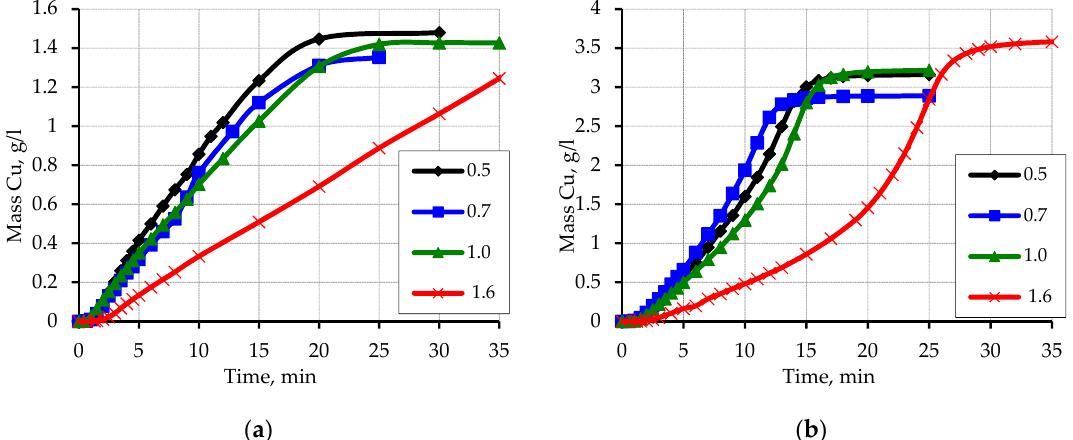
Figure 7. Kinetic curves of copper ion reduction on the activated surface of polypropylene depending on the particle size. Concentration (mmol / L): ( a ) CuSO 4 –48; EDTA-Na 2 –67; NaOH–560; formaldehyde–366. ( b ) CuSO 4 –80; EDTA-Na 2 –67; NaOH–560; formaldehyde–366.